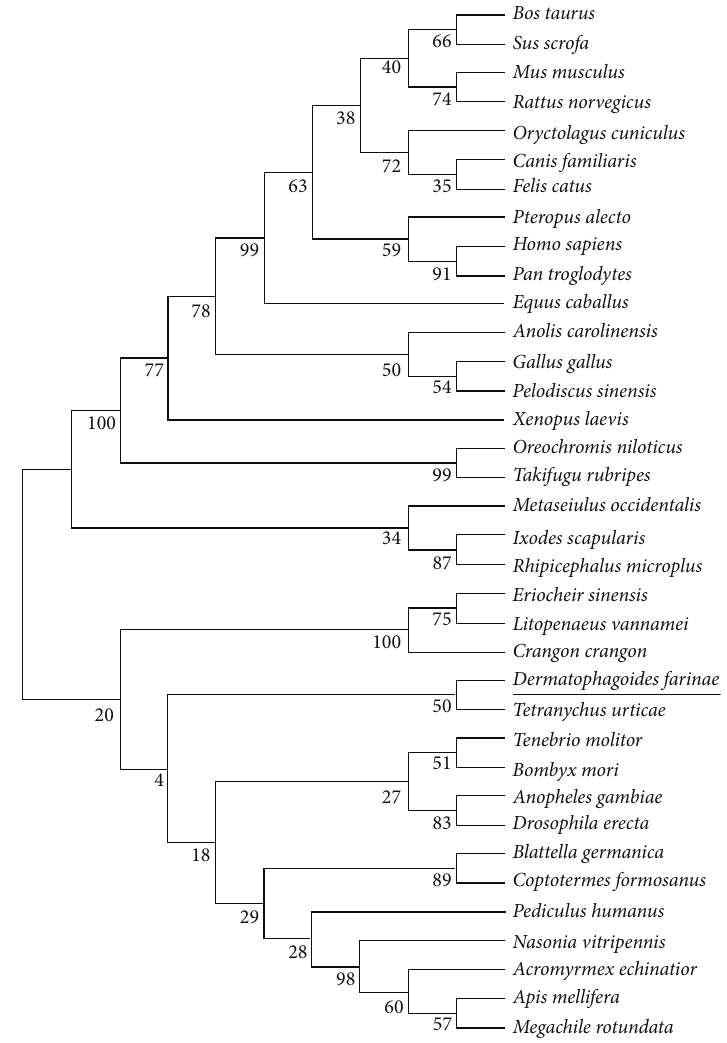
Figure 1: Phylogenetic relationship of Der f 25 amino acid sequence with other